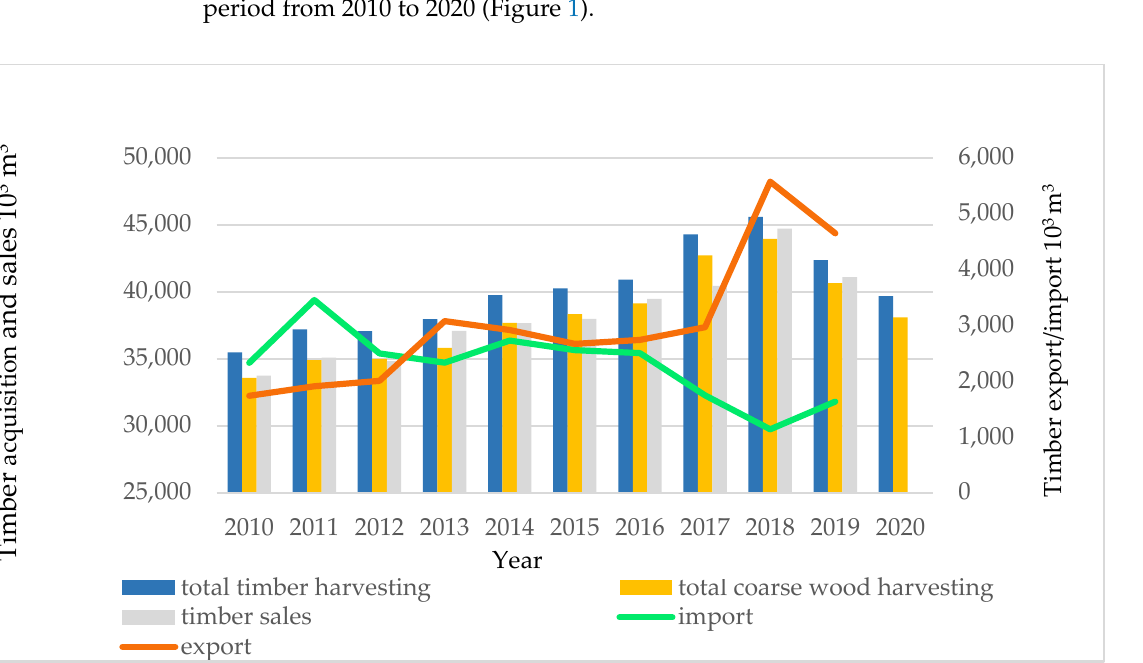
Figure 1. Acquisition, sale, export and import of wood Source: own elaboration based on Statistical Yearbooks of Forestry Source: own elaboration based on available publications